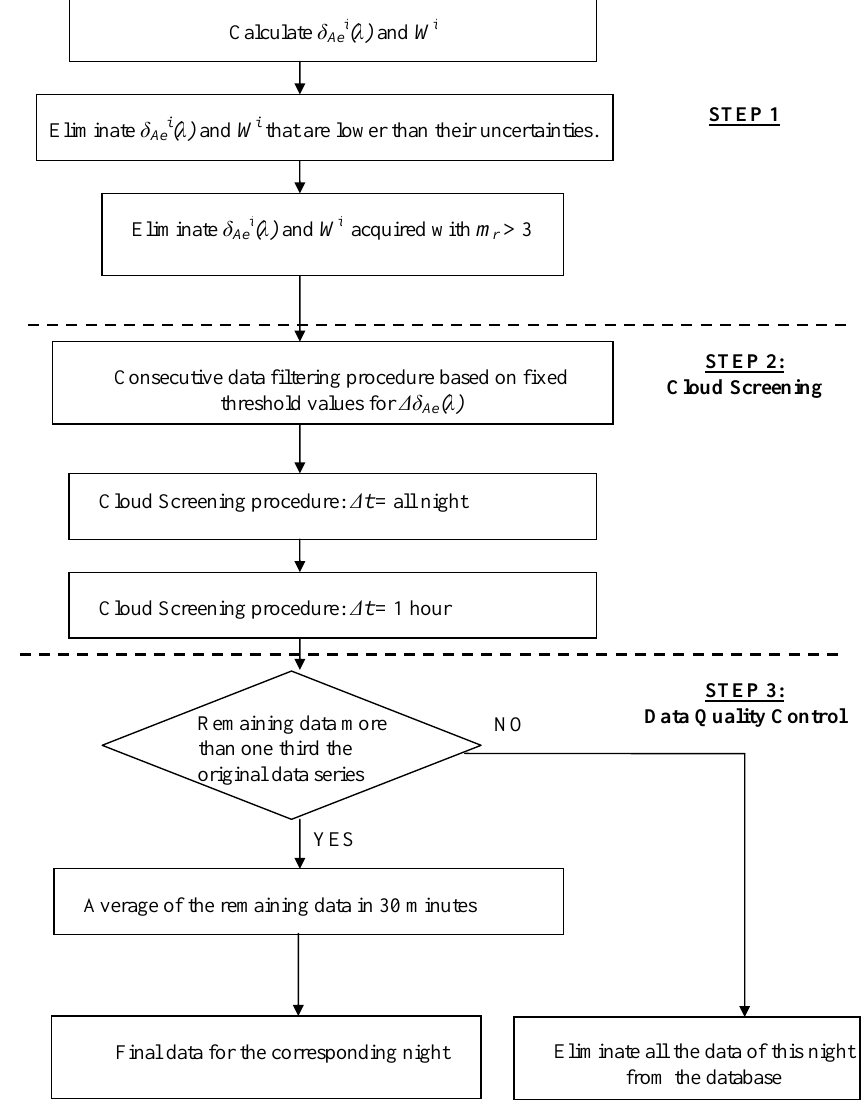
Fig. 1. Flow diagram of the cloud screening and quality control algorithm for star photometry. The parameter ∆ t refers to the time-interval used for calculating the moving-averages. “ ∆ t = all-night” is the time between the first and the last measurement in each night. The δ Aei ( λ ) data point is not included in the computation of its corresponding moving-average δ Aei,M ( λ ).